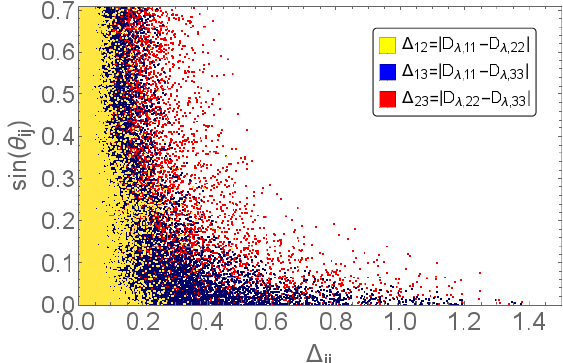
Figure 4 . Viable ranges for the (cid:13)avour mixing angles (cid:18) ij of the quark doublet DMFV model in dependence of the splittings between couplings D (cid:21);ii and D (cid:21);jj , for mediator mass m (cid:30) = 850 GeV and DM mass m (cid:31) = 250 GeV. Di(cid:11)erent colours correspond to the di(cid:11)erent mixing angles (cid:18) ij and splittings j D (cid:21);ii (cid:0) D (cid:21);jj j = (cid:1) ij , with each colour representing one pair of indices: ij = 12 in yellow, ij = 13 in blue, ij = 23 in